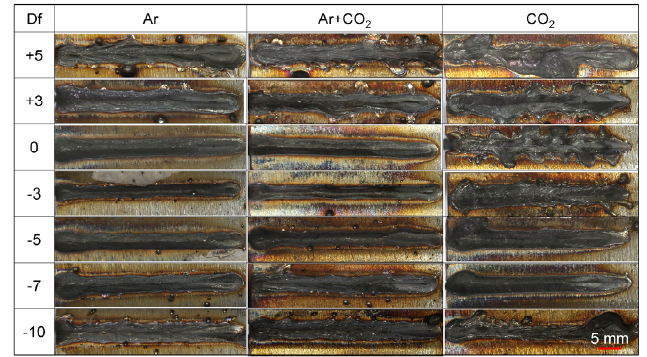
Figure 1. Weld appearances under different shielding gases and Df.